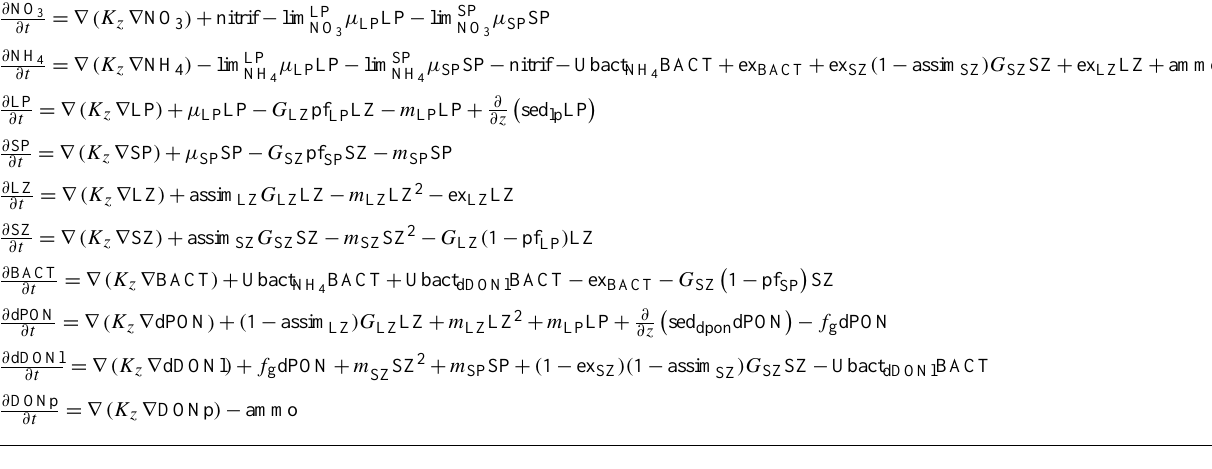
Table 1. Differential equations for the 10-component plankton ecosystem model: nitrate (NO 3 ) , ammonium (NH 4 ) , large and small phyto- plankton (LP and SP, respectively), large and small zooplankton (LZ and SZ, respectively), bacteria (BACT), detrital particulate and dissolved organic nitrogen (dPON and dDONl, respectively), and photosensitive dissolved organic nitrogen (DONp).